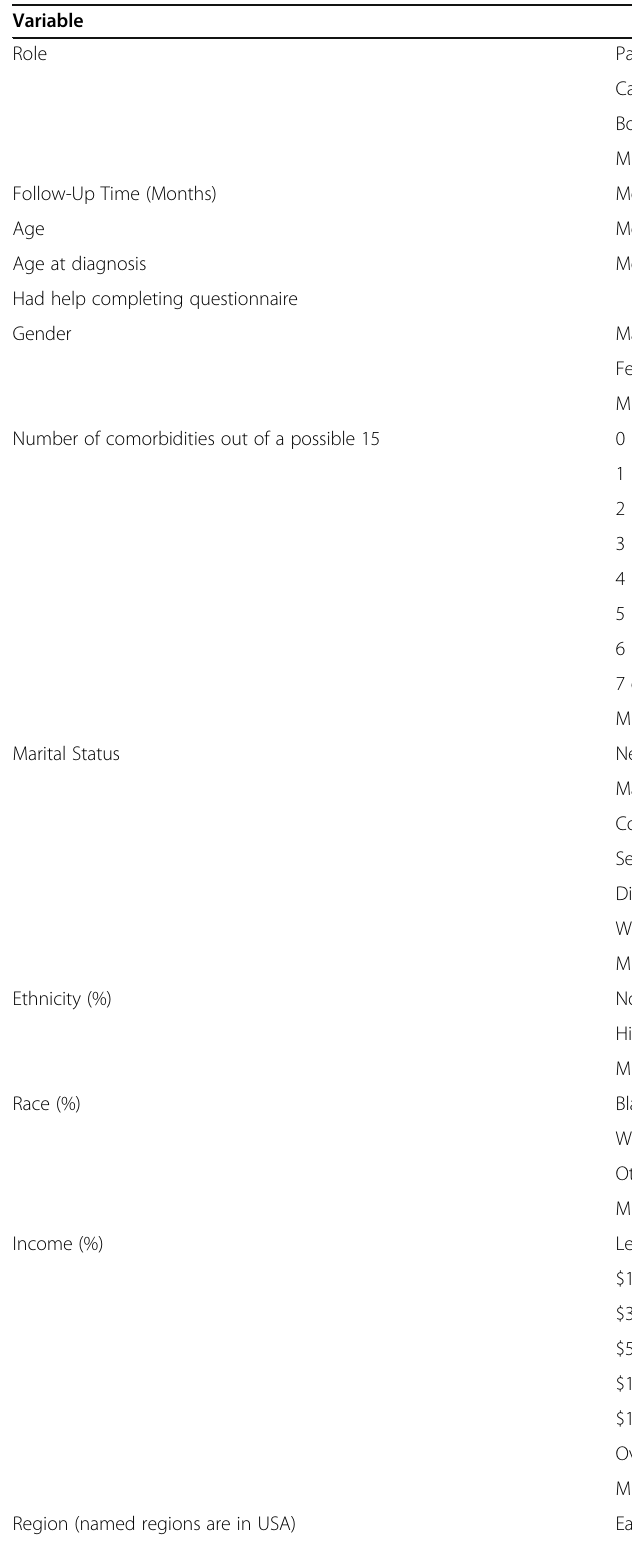
Table 1 Person-Level Demographic Characteristics ( N =